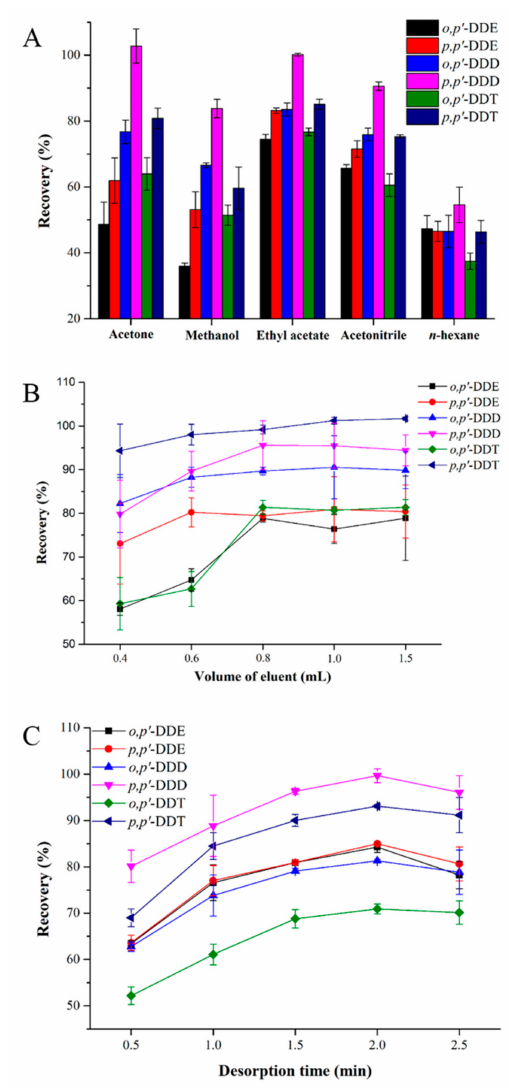
Figure 3. E ff ect of di ff erent desorption conditions on the desorption performance of DDTs: ( A ) type of eluent, ( B ) volume of eluent, and ( C ) desorption